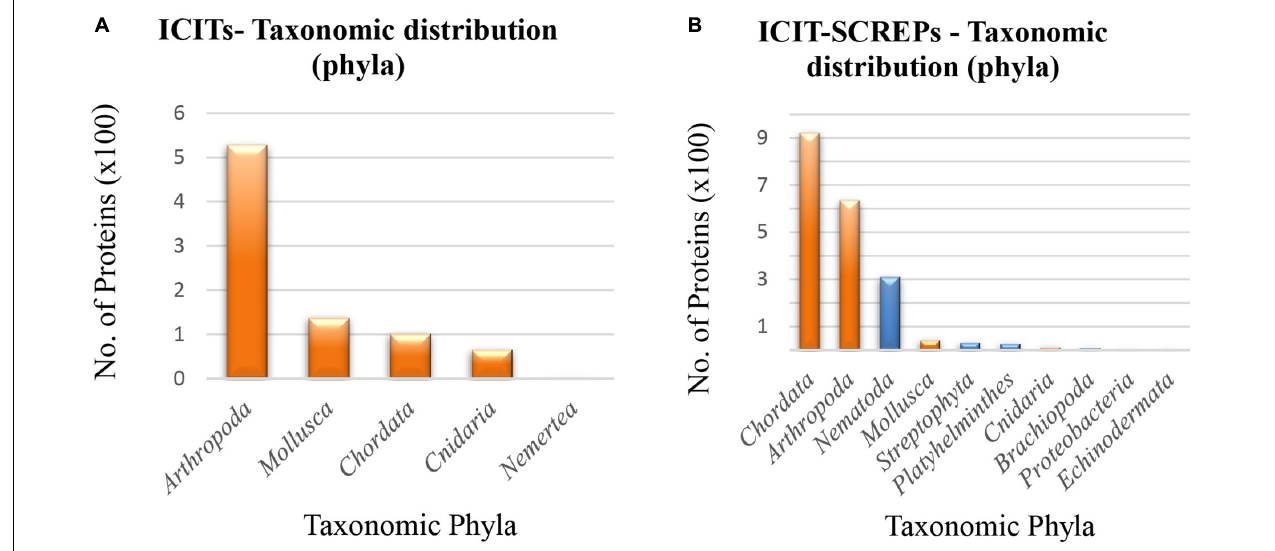
FIGURE 8 | Taxonomic distribution of ICITs and ICIT-SCREPs. (A) The taxonomic distribution of phyla within the refined ICIT dataset. (B) The taxonomic distribution of SCREPS that display homology with the refined ICITs “ICIT-SCREPs,” orange indicating the overlap of taxonomic phyla with the ICITs.